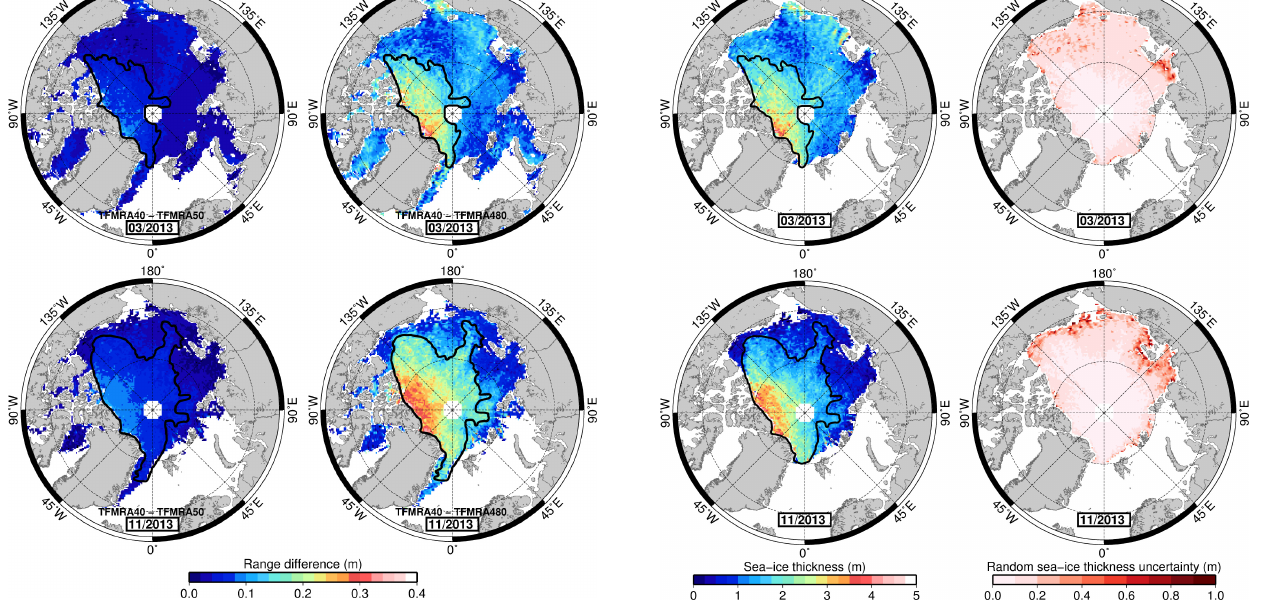
Figure 12. (a) CryoSat-2 Arctic sea-ice thickness from March and November 2013, applying the 50% threshold. (b) Random thick- ness uncertainties corresponding to (a) . The black polygon defines the averaged MYI zone, retrieved from the OSI SAF ice-type prod-